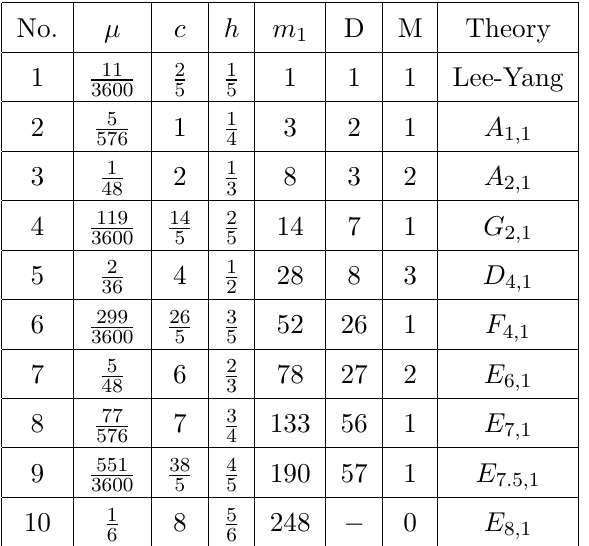
Table 1 . The MMS